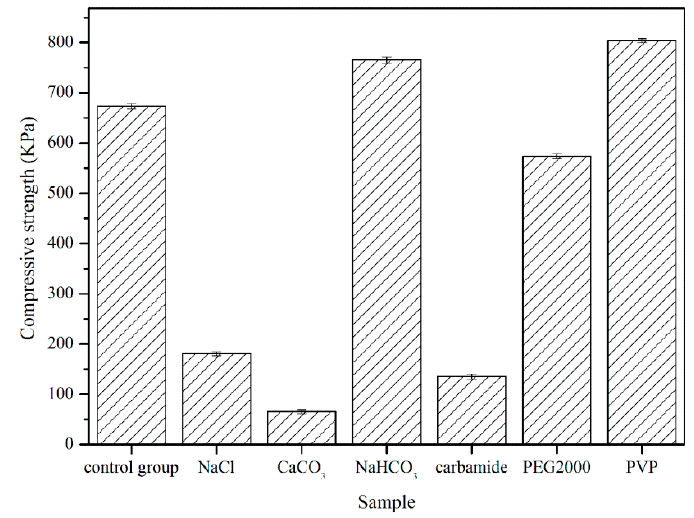
Figure 2. Compressive properties of hydrogels with or without six kinds of pore-forming agents.